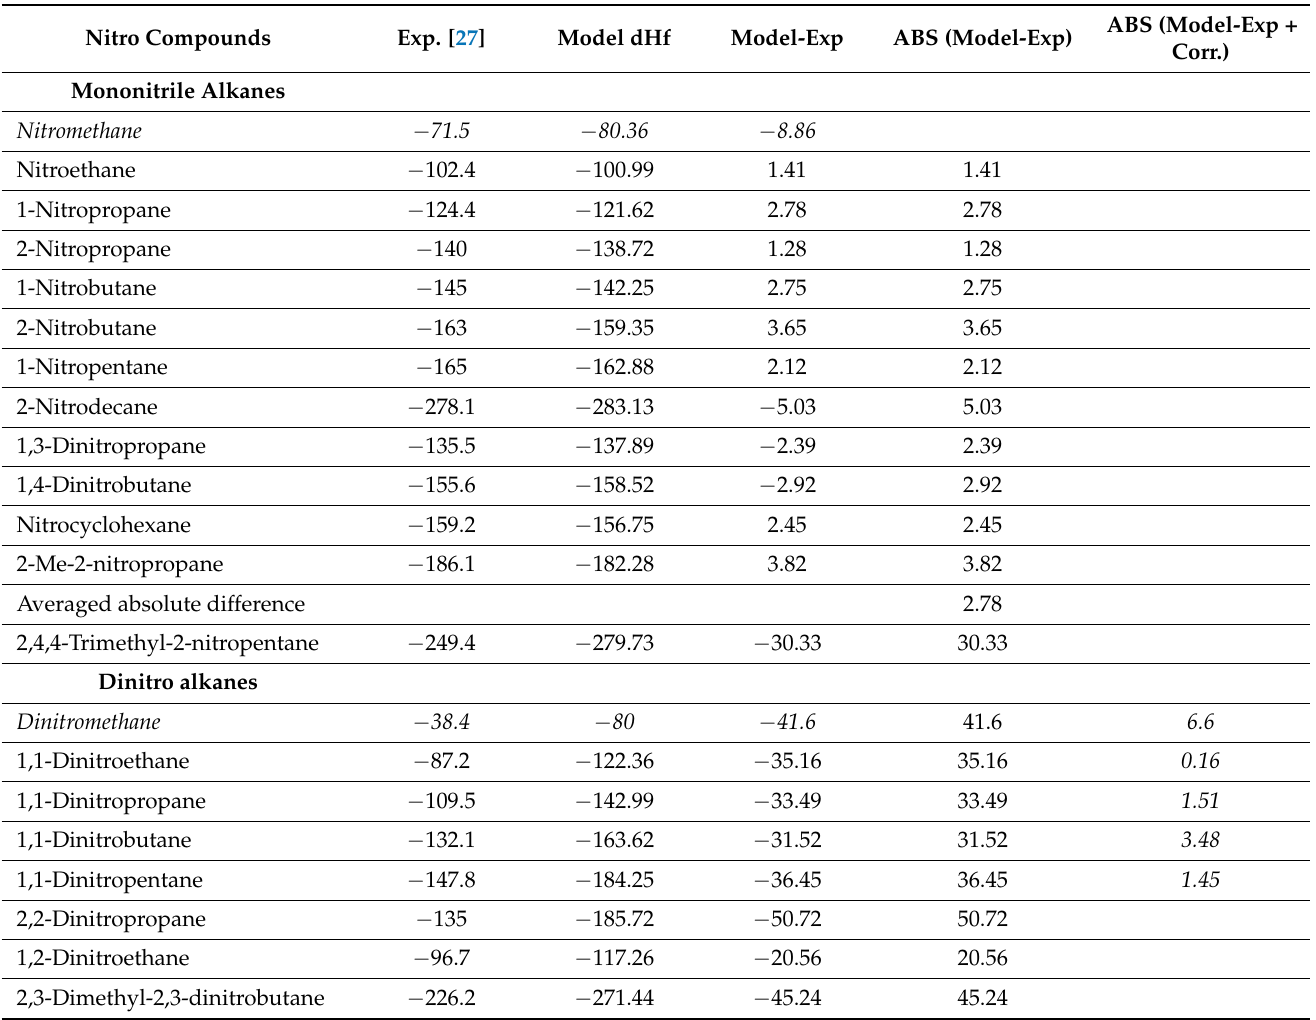
Table 5. Experimental and model values for nitroalkanes. All values in kJ/mol. In the third column entitled “model dHf”, the corrections related to alkyl-substituted alkanes were accounted for, e.g., correction for 2-Me to terminal Me group interaction. In the final column, the interaction correction term for two nitro groups attached to the same carbon atom was added, with the value being 35 kJ/mol (see